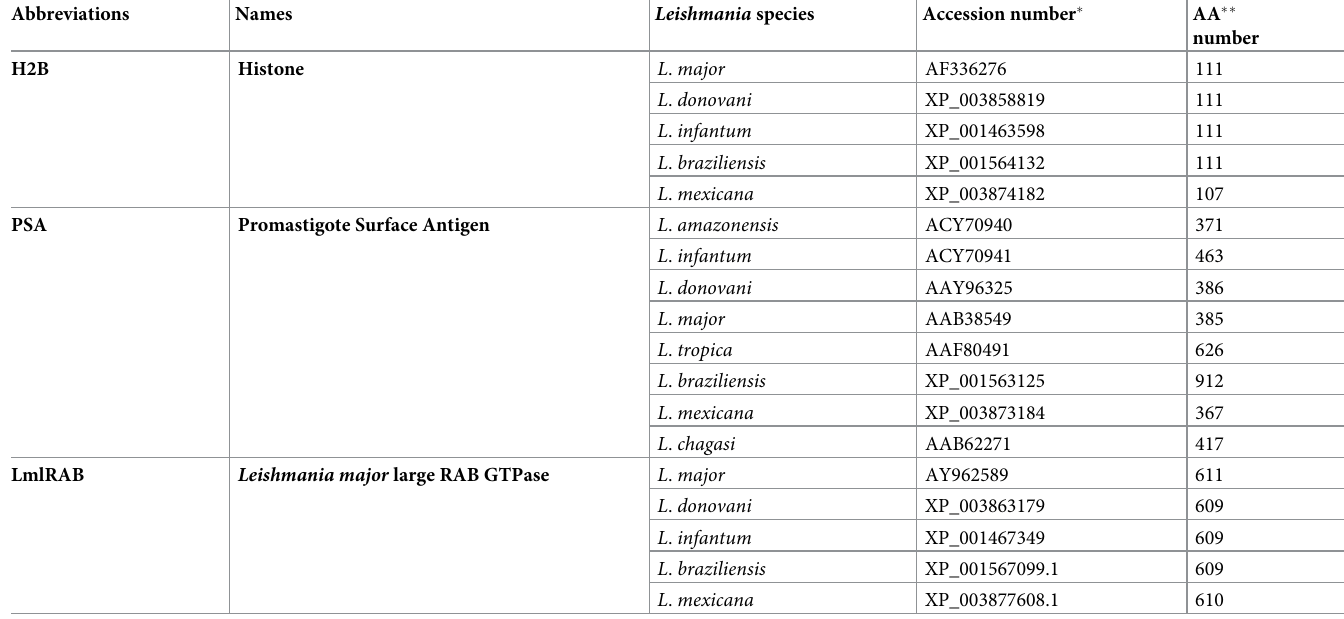
Table 2. Leishmania proteins used as candidate antigens for epitope